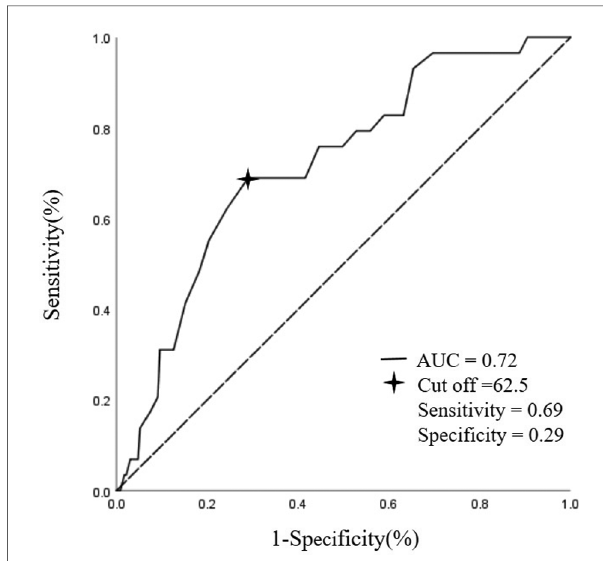
FIGURE 2 Age correlated with prediction of clavien-dindo score ≥ 3b in ROC curve analysis. AUC, area under curve.